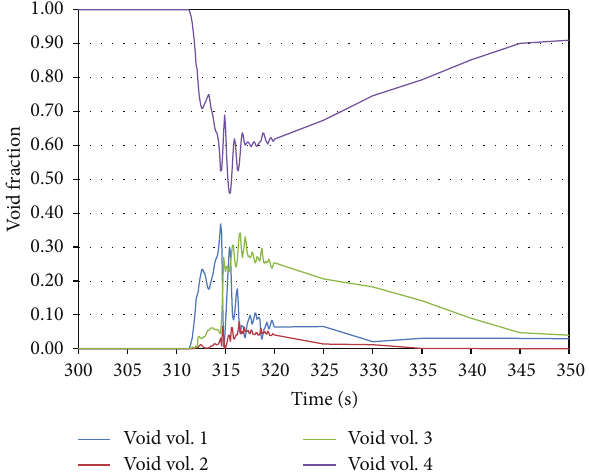
Figure 5: Void fraction in PSP during the first seconds of the LOOP.